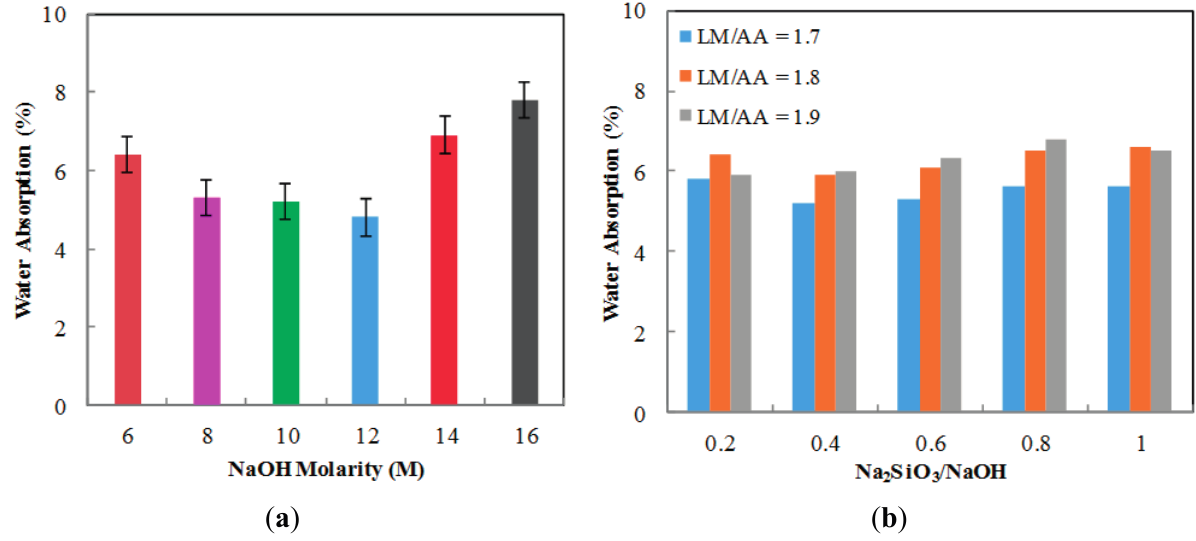
Figure 2. The water absorption of ALGA at ( a ) various NaOH molarity; ( b ) various LUSI mud/Alkaline activator (LM/AA) ratio and Na 2 SiO 3 /NaOH